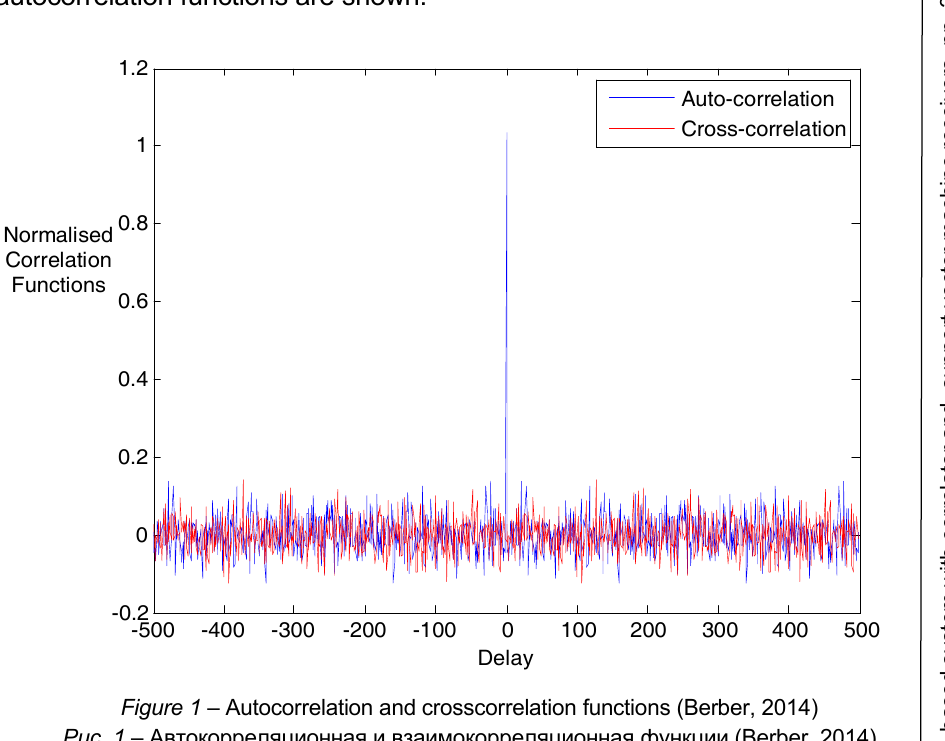
Figure 1 – Autocorrelation and crosscorrelation functions (Berber, 2014) Рис . 1 – Автокорреляционная и взаимокорреляционная функции (Berber,